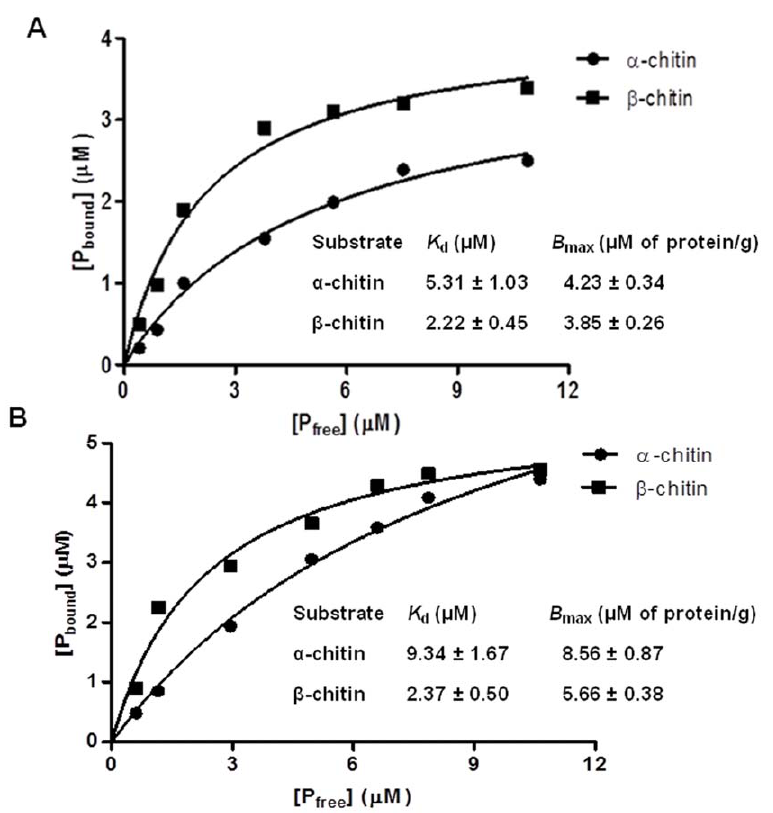
Figure 2. Equilibrium adsorption isotherms of Sp CBP21 and Sp CBP50 to a - and b -chitin. The reaction assay (1 mL) containing 1.0 mg substrates ( a - and b - chitin) and varied concentrations of Sp CBP21 and Sp CBP50 starting from 0 to 10.0 m M was incubated ( Sp CBP21 with a - and b - chitin, 12 h and 6 h, respectively; Sp CBP50 with a - and b -chitin, 12 h) at 37 u C. The reaction mixtures were centrifuged and concentration of bound protein (P bound ) and un-bound free protein (P free ) was determined and plotted to fit into GraphPad Prism software version 5.0. All data sets were fitted to the equation for one-site binding by non-linear regression function, and to calculate B max and K d using GraphPad Prism software version 5.0. (A and B) The K d and B max values of Sp CBP21 and Sp CBP50 were shown in the inset table.